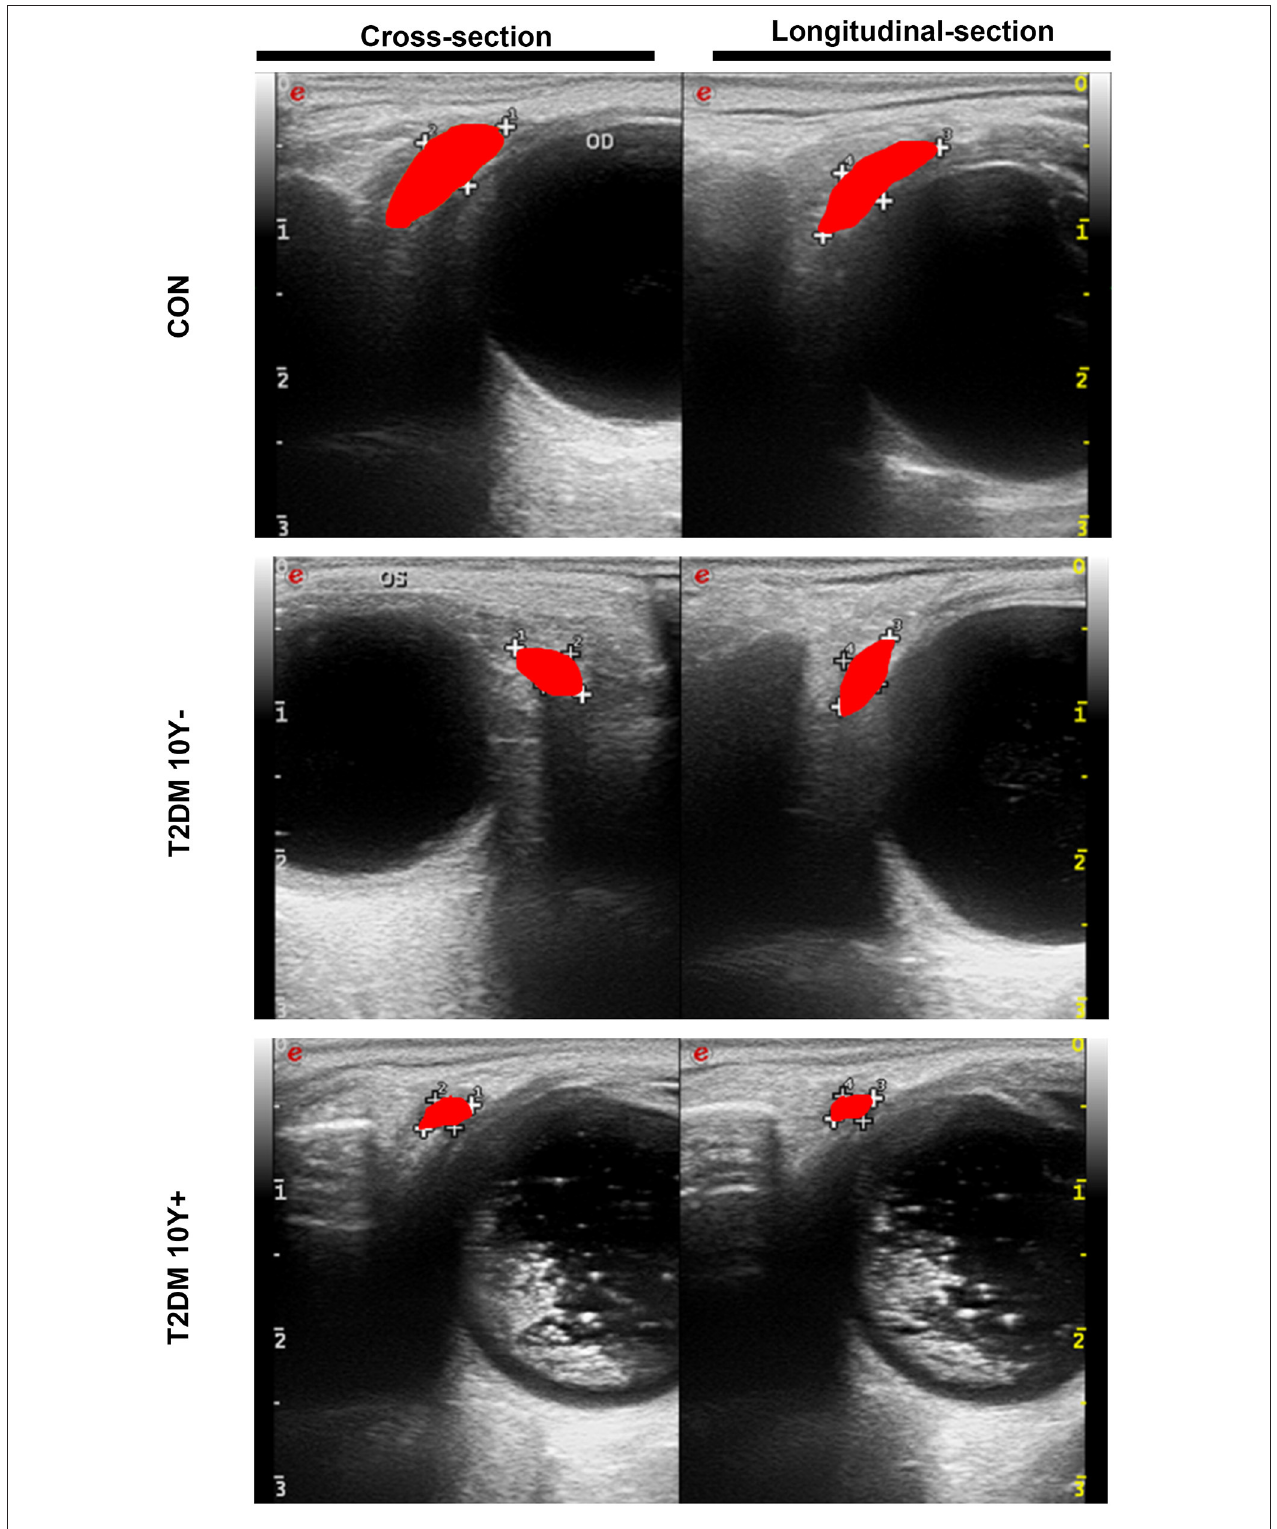
FIGURE 2 | Morphological changes of LGs in patients with type 2 diabetes and control by CDFI. LGs from patients with T2DM and controls were measured by CDFI in two dimensions including the cross-section and longitudinal-section to demonstrate the morphological changes. The red area indicates the position and size of the LG. T2DM 10Y-, diabetic duration < 10 years; T2DM 10Y + , diabetic duration more than 10 years; LG, lacrimal gland.